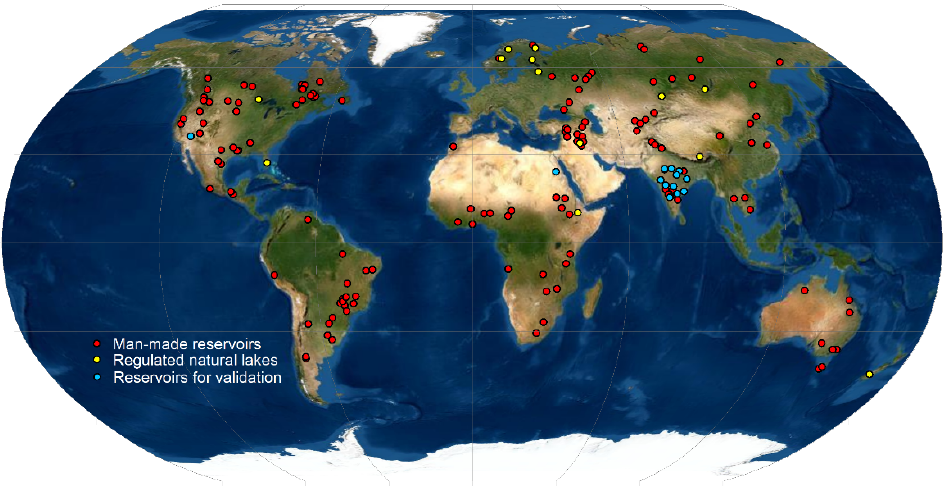
Figure 1. Locations of the 151 man-made reservoirs (in red and blue) and 13 regulated natural lakes (in yellow) are contained in this product. The reservoirs labeled in blue are used for validation purposes.